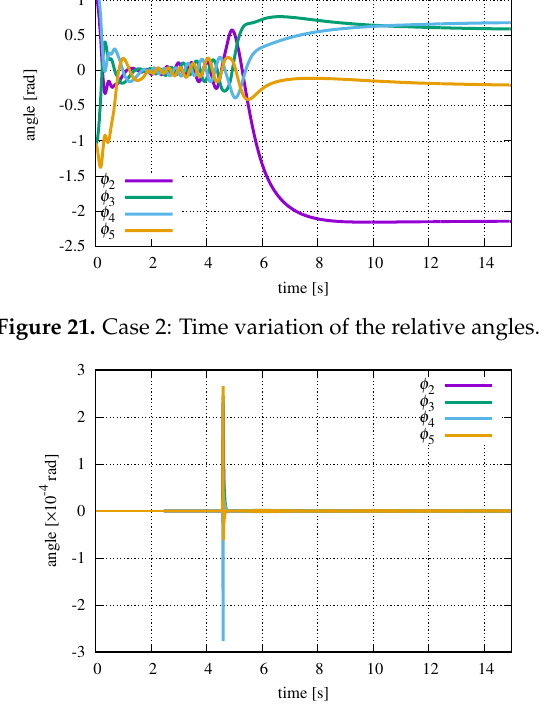
Figure 22. Case 2: Time variation of estimation error of the relative angles.